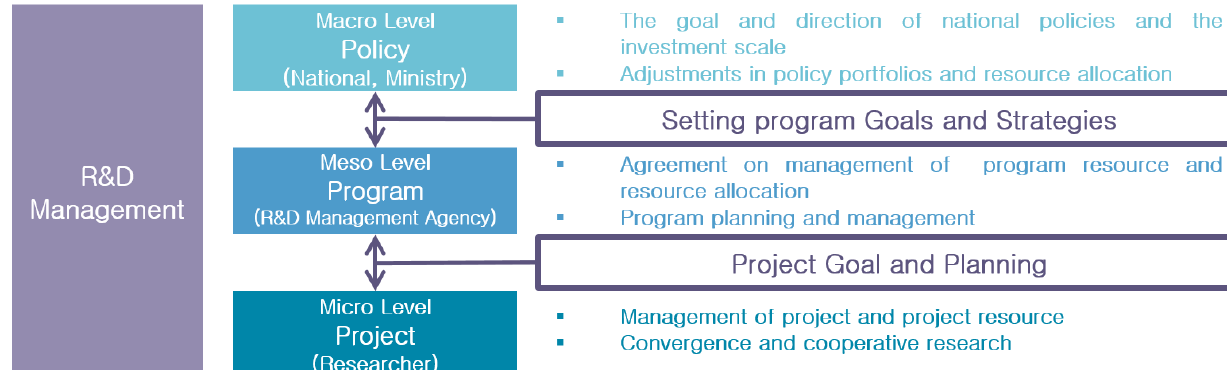
Figure 2. Levels of managing science and technology policies, programs, and projects. Source: The Impact of Organizational Competencies on the Performance of R&D Management Agencies in Korea. Hong et al. (2018) [5], Hwang et al. (2019) [6].